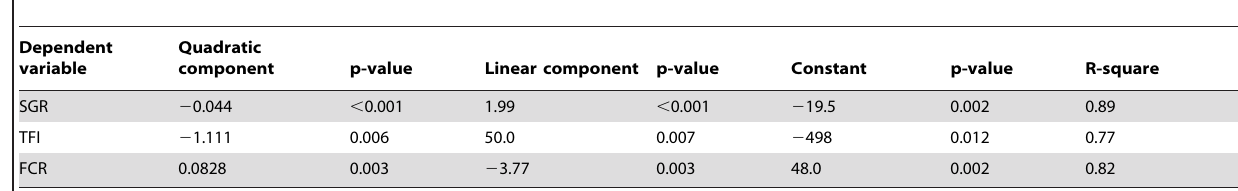
Table 4. Results of the second order polynomial regression for specific growth rate (SGR), total feed intake (TFI) and feed conversion ratio